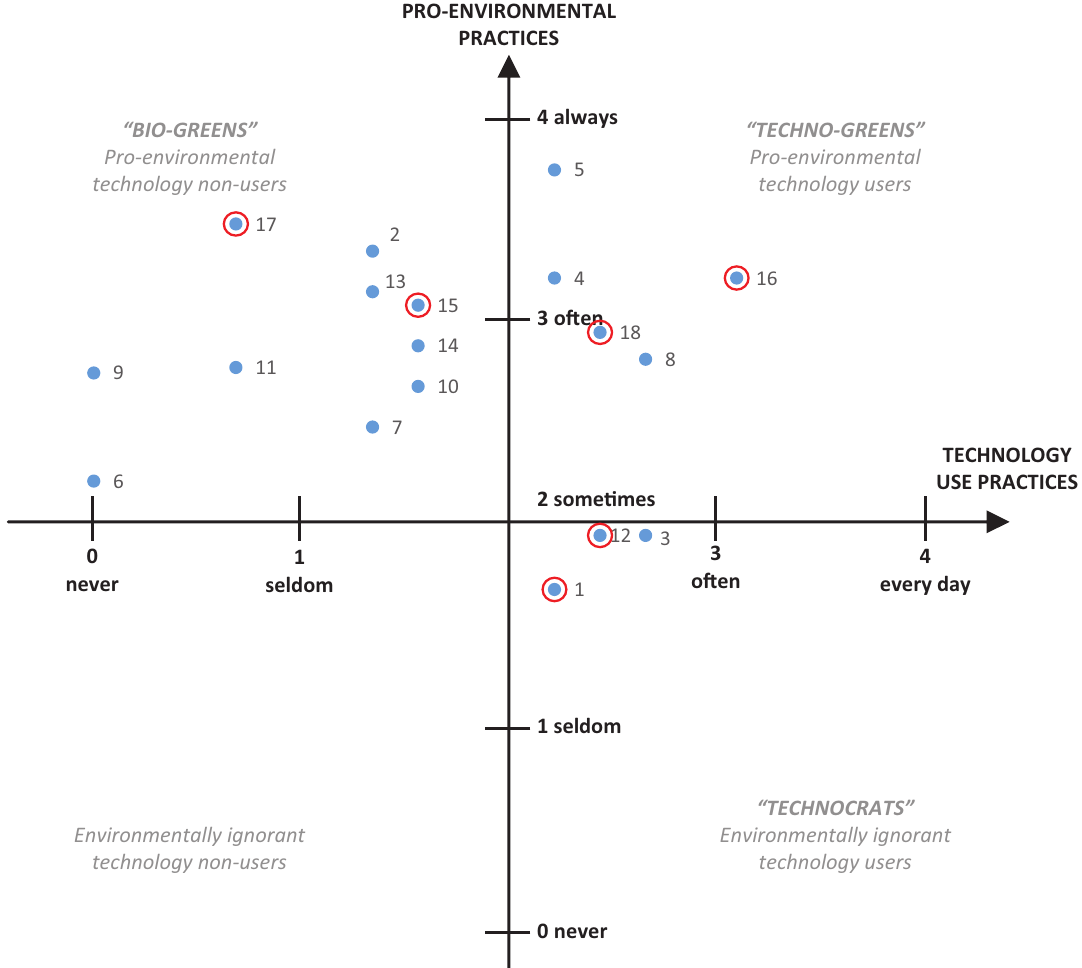
Figure 3. Respondents’ positions on the axes of pro‐environmental and technology use practices. Blue dots indicate respon‐ dents and red circles indicate those who also participated in the in‐depth